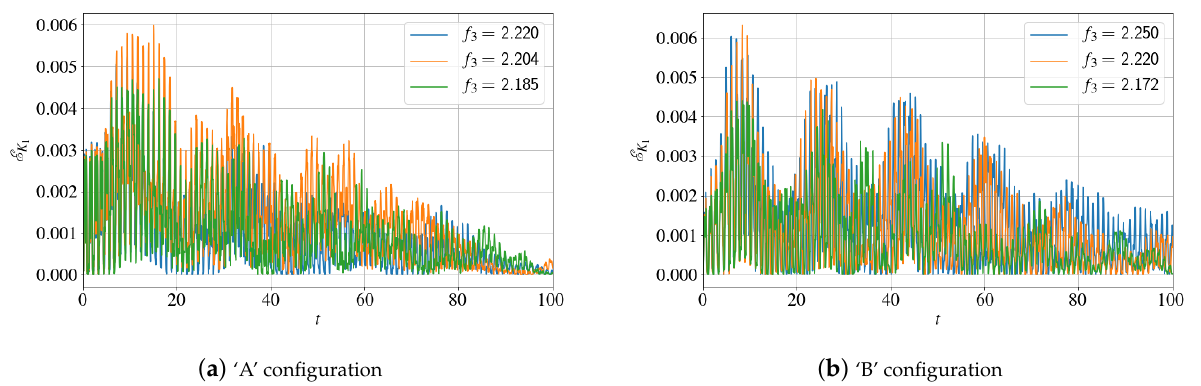
Figure 9. Time series for the efficiency E k (23) (relative amplitude) for the K 1 target mode for encountering wave-packets, case A on the left and B on the right. In case A the peak of energy transfer observed in K 1 is at the frequency ( f 3 / Hz ≈ 2.204, K 3 = 1246 2 π ) and is here compared to off resonance ( f 3 / Hz = 2.22, K 3 = 1264 2 π and f 3 / Hz = 2.185, K 3 = 1224 2 π ). L L L In case B the peak of energy transfer observed in K 1 is at the frequency ( f 3 / Hz ≈ 2.22, K 3 = 1264 2 π ) and is here compared L to off resonance ( f 3 / Hz = 2.25, K 3 = 1298 2 π and f 3 / Hz = 2.172, K 3 = 1210 2 π L L